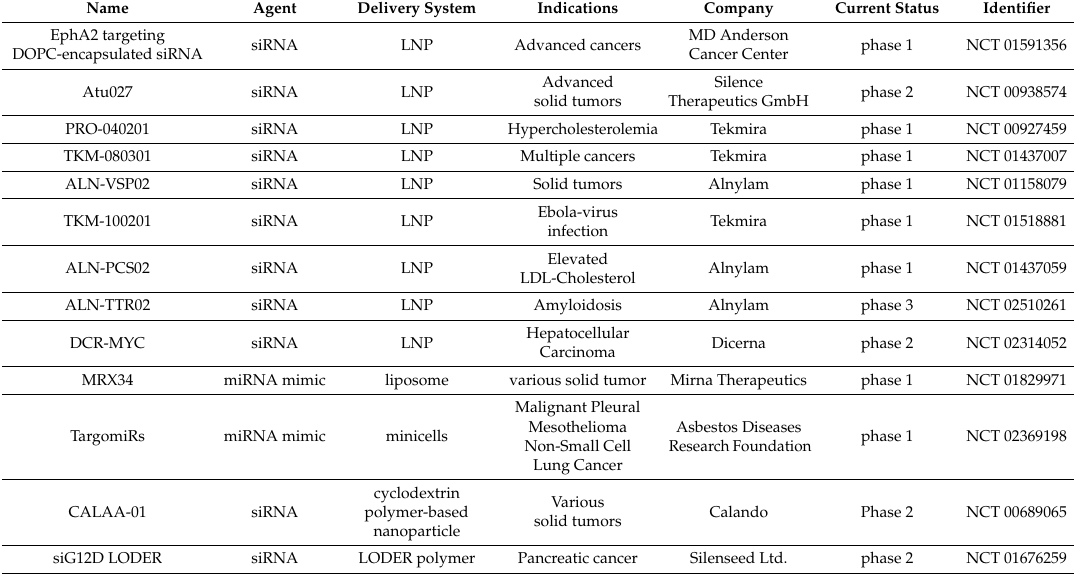
Table 1. Status of various ncRNA-based nanomedicine under clinical